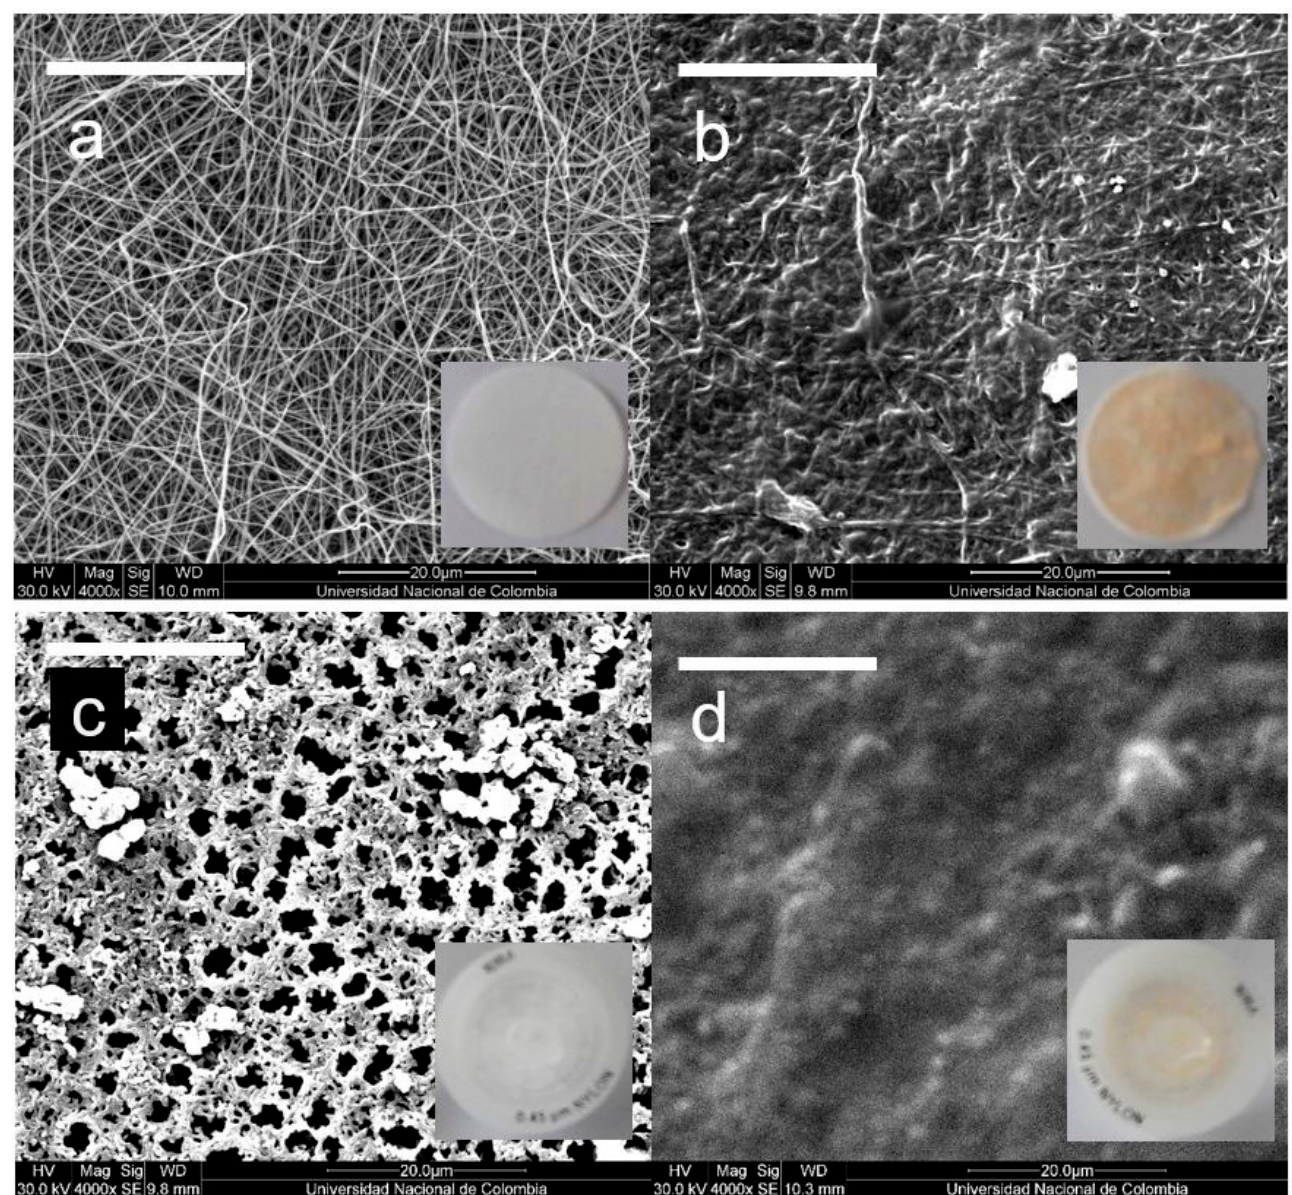
Figure 3. SEM images of the typical morphology of NFM ( a ) before and ( b ) after filtration, compared to the typical morphology of CM ( c ) before and ( d ) after filtration. In the inserts, the corresponding macroscopic appearance of the filters. Filtration conditions: 10 mL of grapefruit juice (pink variety). White bars correspond to 20 μ m.